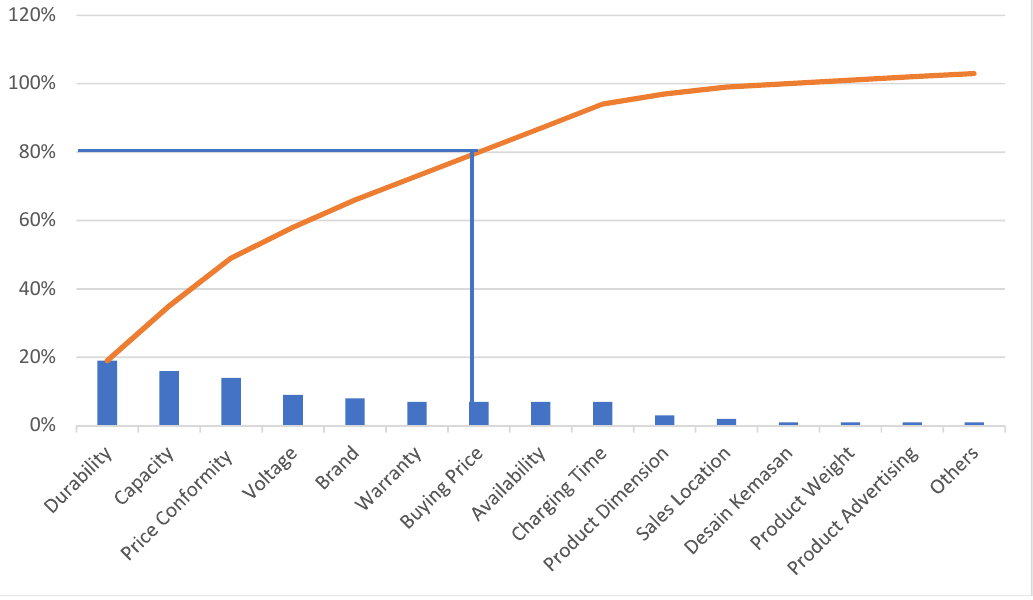
Table 1. Prime Algebra Matrix.